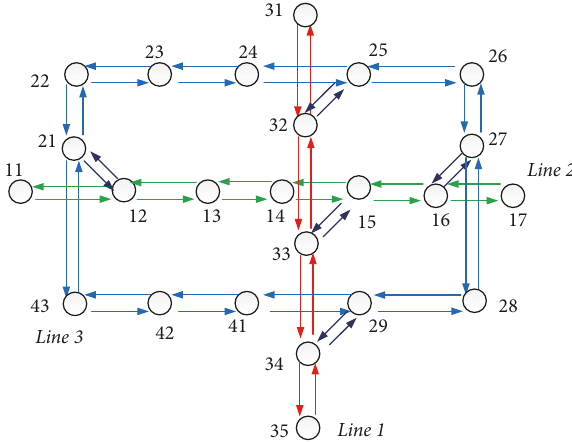
Figure 4: A grid network for illustrating solution